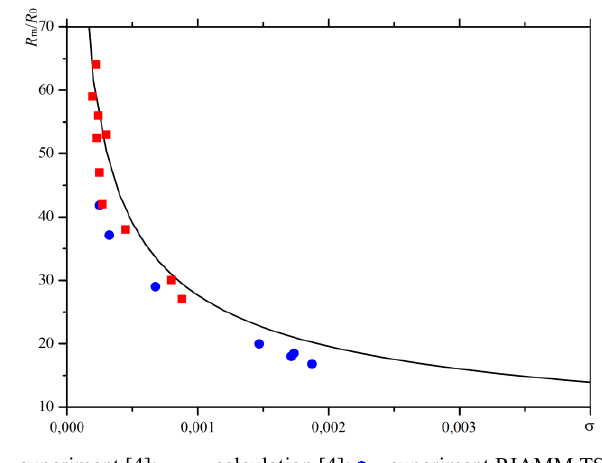
Fig. 6. Cavity midsection R m to cavitator radius R c ratio dependencies on cavity number σ is obtained in this work and the results published in